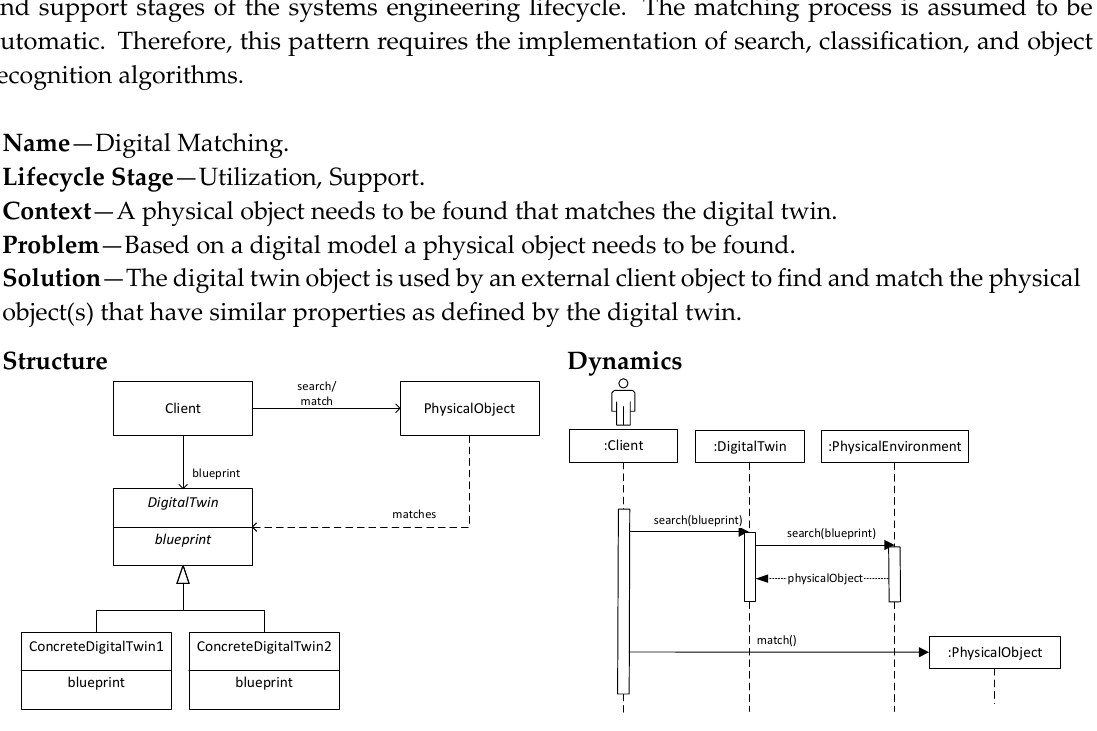
Figure 10. Digital Matching pattern.